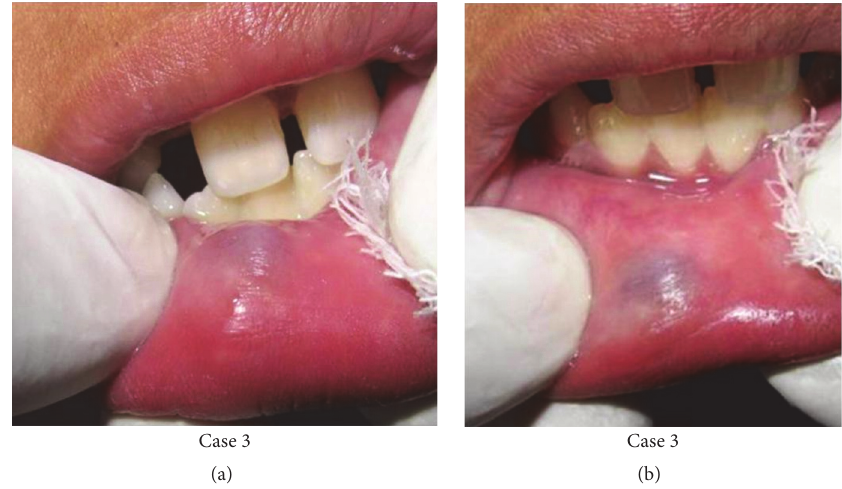
Figure 3: Case 3 showing mucocele in right lower labial mucosa of 10 ∗ 8 mm size (a) and decrease in size of lesion to 3 ∗ 2 mm